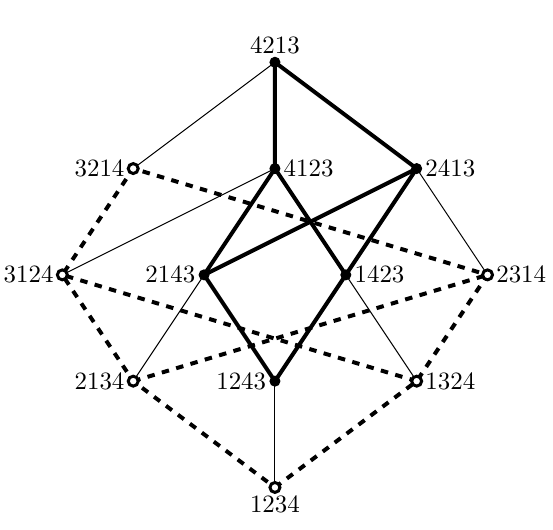
Fig. 4: The principal order ideal Λ 4213 has a copy of the principal order ideal Λ 321 , both as a principal order ideal (thick dashed lines) and as a generic interval (thick solid